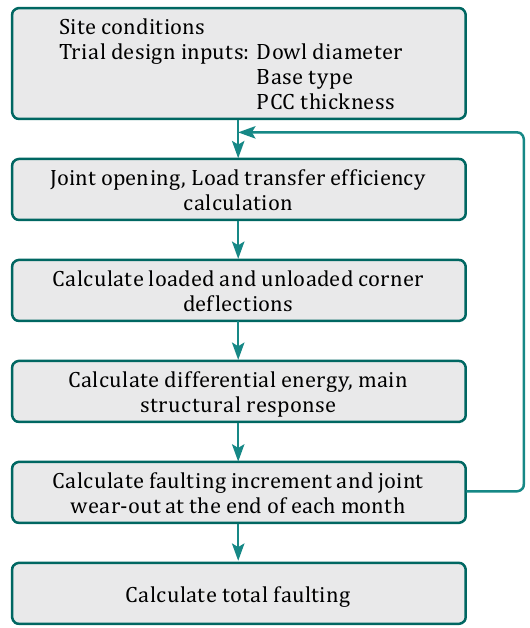
Figure 1. Concrete pavement design based on transverse joint faulting (Khazanovich, Darter, & Yu,